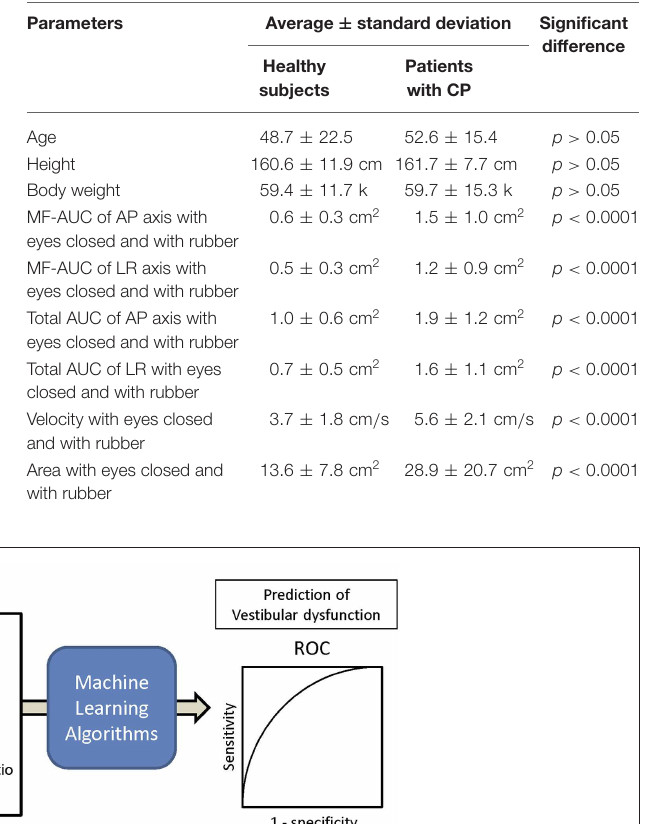
TABLE 1 | The basic physical parameters and posturography results.